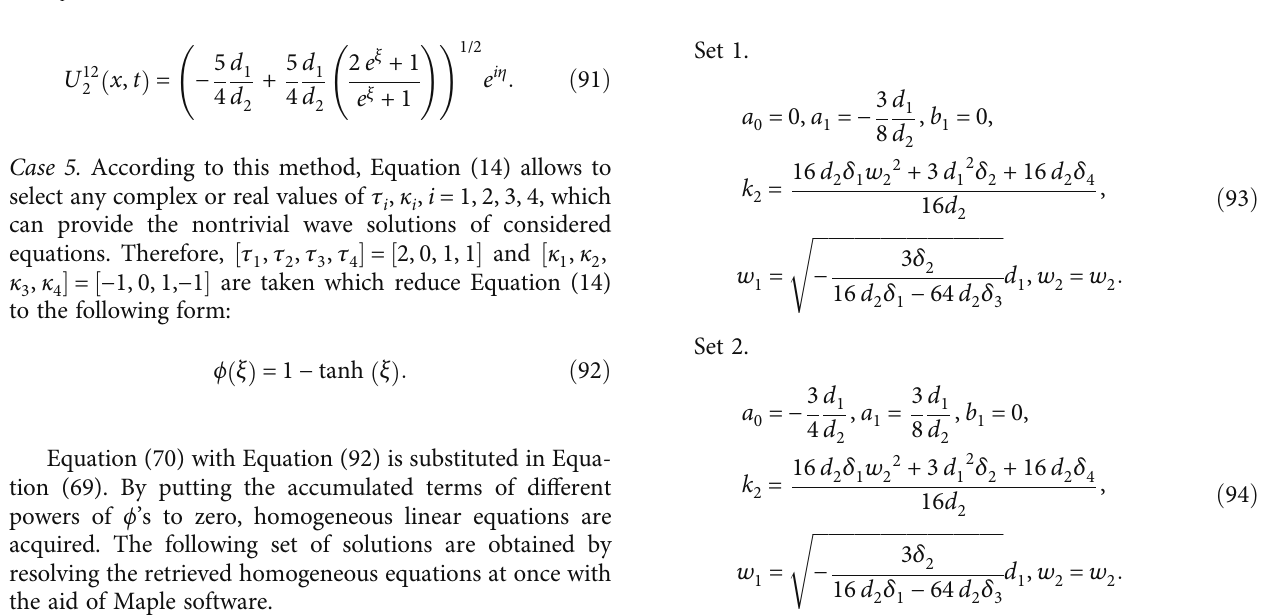
ð x , t Þj for NLFD of order α and for parameters δ 1